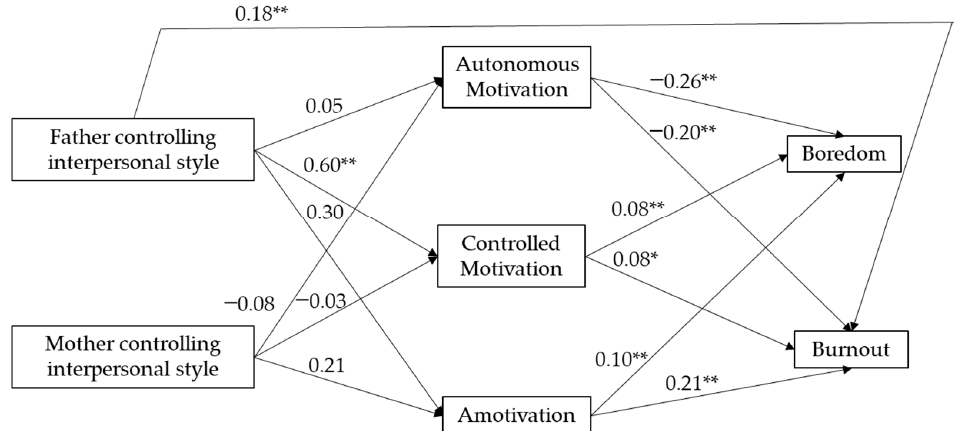
Figure 3. Unstandardized solution of the relationship between parents’ controlling interpersonal style, forms of motivation, boredom, and burnout. * p < 0.05; ** p < 0.01.